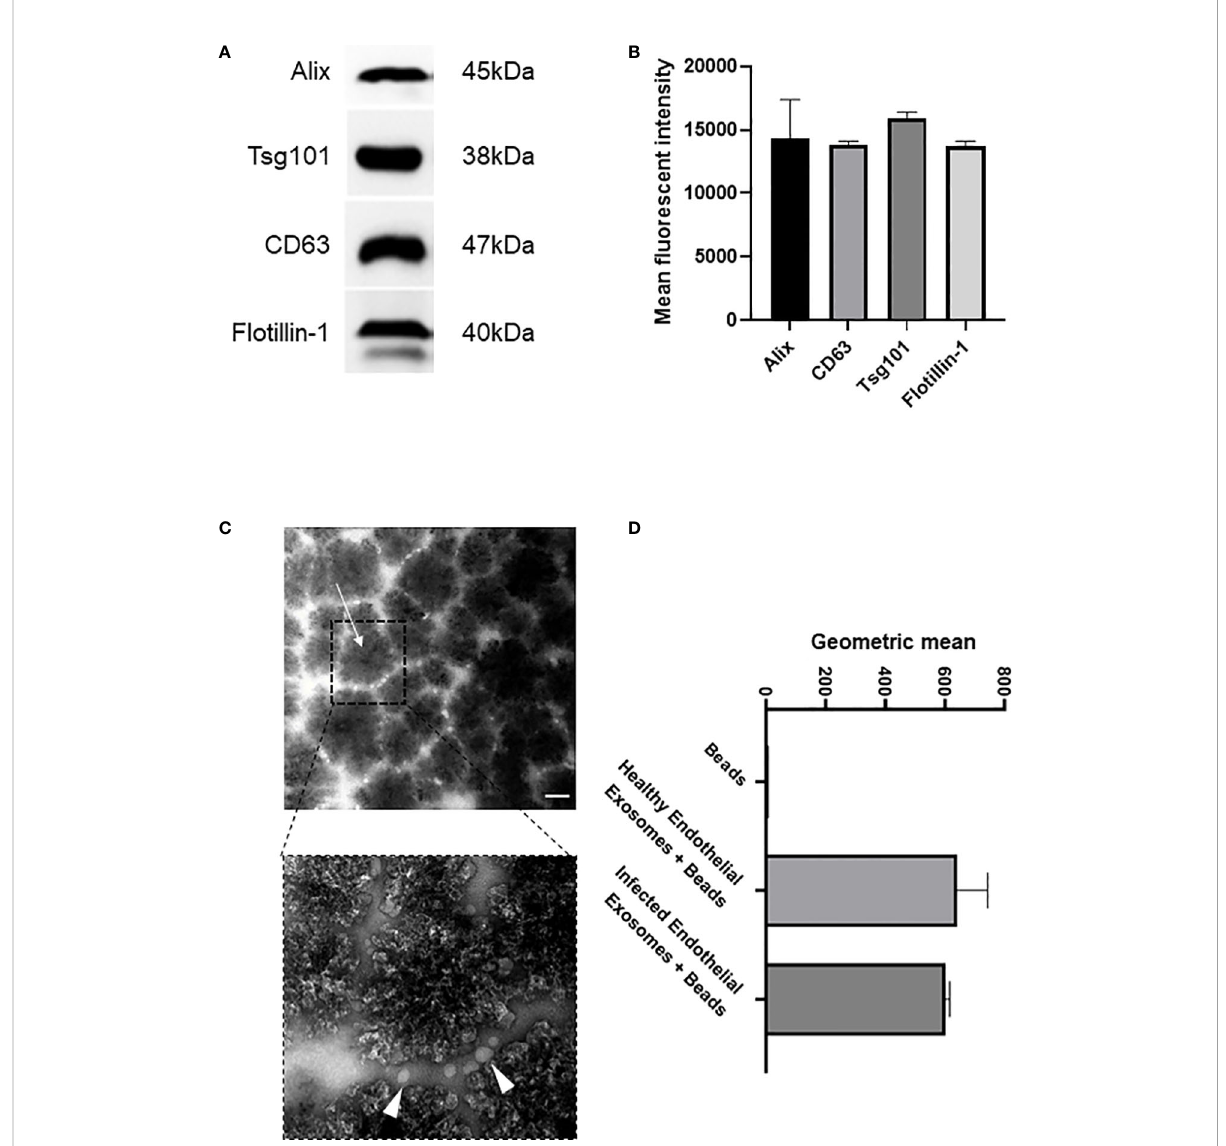
FIGURE 1 Isolation and characterisation of exosomes from healthy and infected endothelial cell supernatant (A) . Immunoblot of exosomal markers Alix (45 kDa), CD63 (38 kDa), Tsg101 (47 kDa), and Flotiliin-1 (40 kDa) isolated from the serum of S. aureus infected endothelial cells and healthy control. Exosomes were isolated by differential centrifugation and nano fi ltration. (B) Densitometry representing western blot data of exosomal markers. (C) Transmission electron microscopy images represent superparamagnetic capture beads incubated with healthy endothelial exosomes and S. aureus infected endothelial exosomes. Images were taken at 50,000X (top) and 150,000X (bottom) magni fi cation. Scale bar: 1 µm. Arrows point towards CD63 bead alone and CD63 bead bound to exosomes. (D) Flow cytometry analysis of CD63 beads bound to either healthy or infected endothelial exosomes. Data is representative of 3 independent